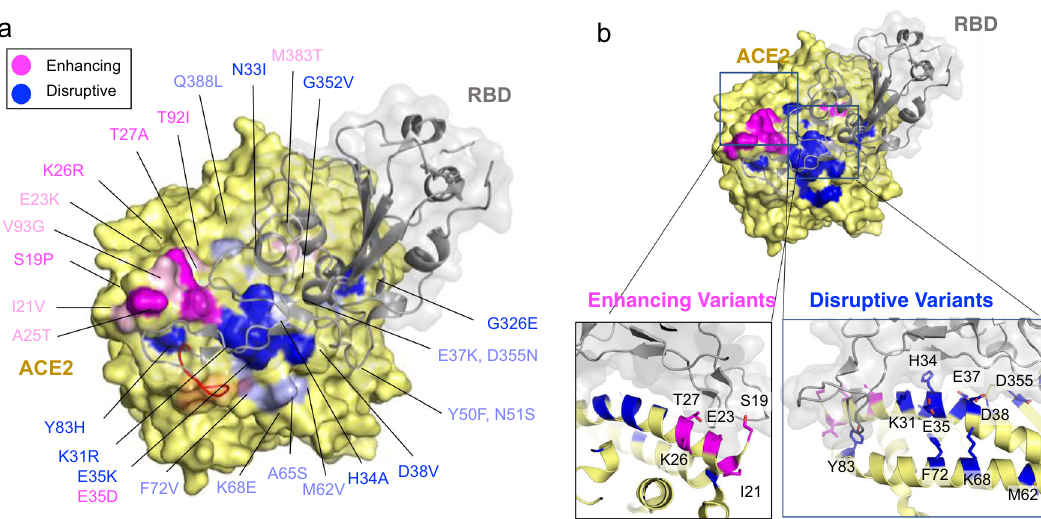
Fig. 2 Human ACE2 polymorphisms mapped to the structure of human ACE2 in complex with the SARS-CoV-2 RBD. Residues in ACE2 showing polymorphic variation in human populations were mapped on to the structure of the ACE2/SARS-CoV-2 RBD (PDB: 6VW1) and colored according to their effect on the predicted af fi nity to SARS-CoV-2 RBD. Polymorphisms that were predicted to enhance the binding between ACE2 and the S-protein are colored in magenta. Polymorphisms that are predicted to disrupt the binding between ACE2 and the S-protein are colored in dark blue. The variable loop in the ridge binding motif consisting of residues V483 and E484 is shown in red. This region in the structure (PDB: 6LZG) is zoomed-in to show variants predicted to enhance or disrupt the ACE2 – SARS-CoV-2